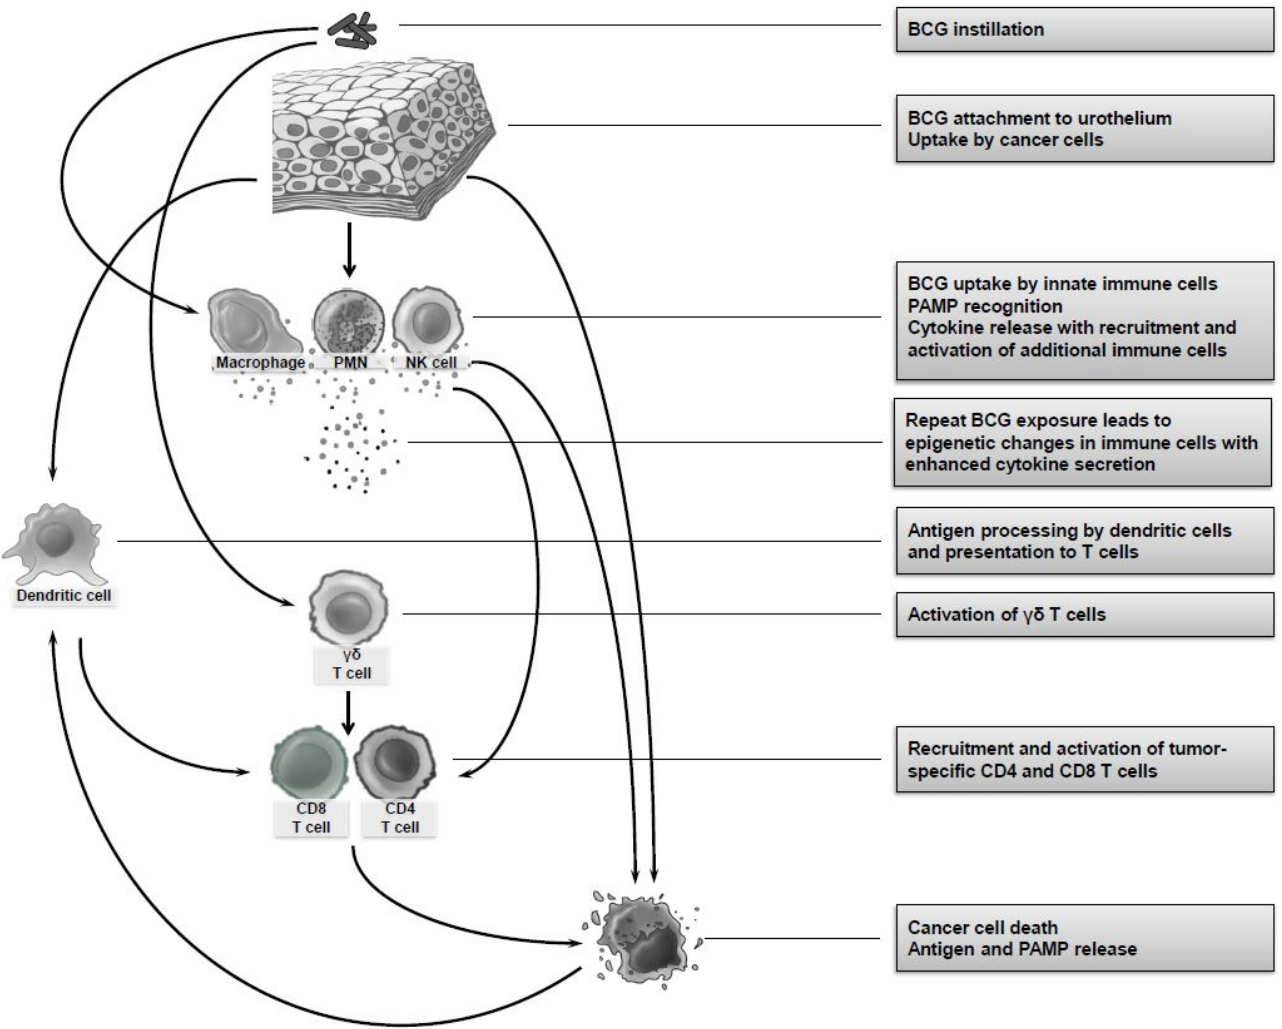
Figure 1. Proposed mechanisms of BCG therapy of bladder cancer.